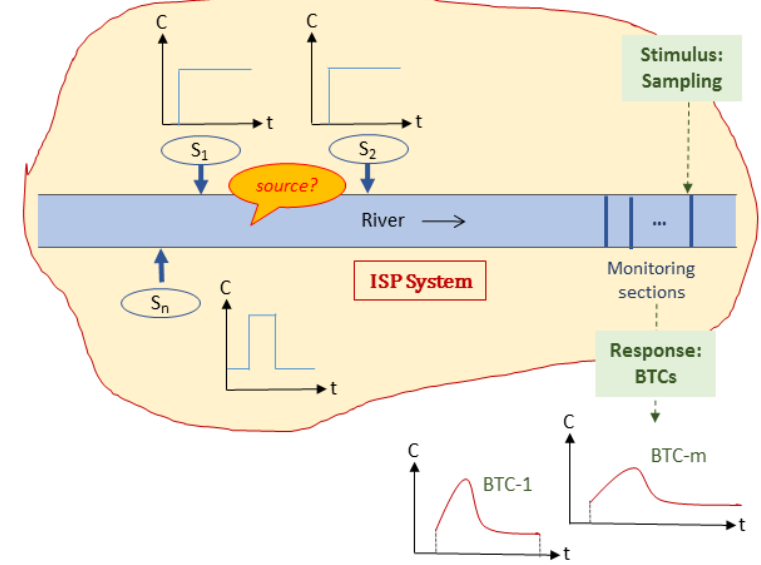
Figure 1. Scheme of the inversion source problem toward river spills from a system theory point of